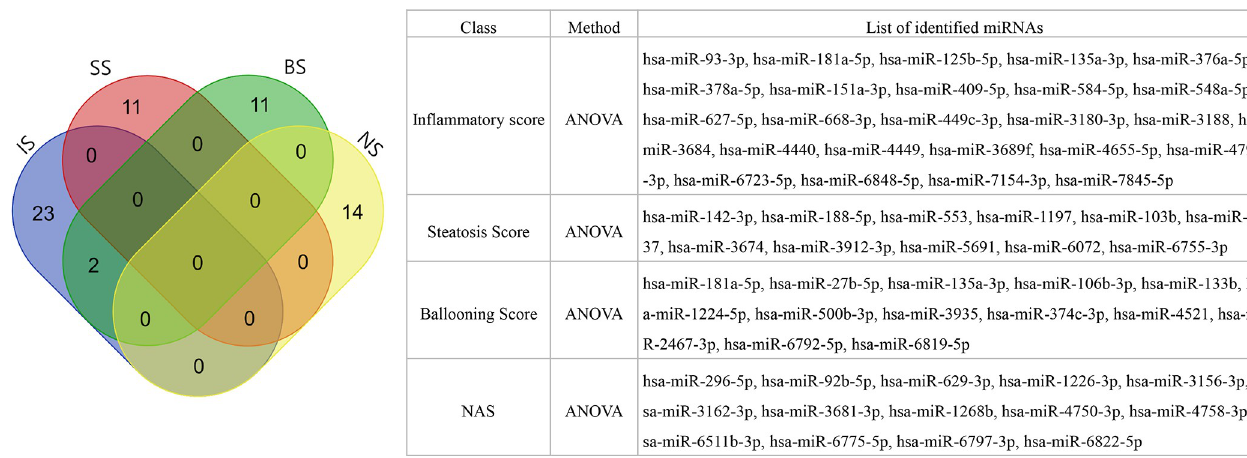
Fig 2. Venn diagram of the miRNAs identified in each of the four variables by analysis of variance (ANOVA). Each identified miRNA is listed in the table. IS, inflammatory score; SS, steatosis score; BS, ballooning score; NAS, nonalcoholic fatty liver disease (NAFLD) activity score.